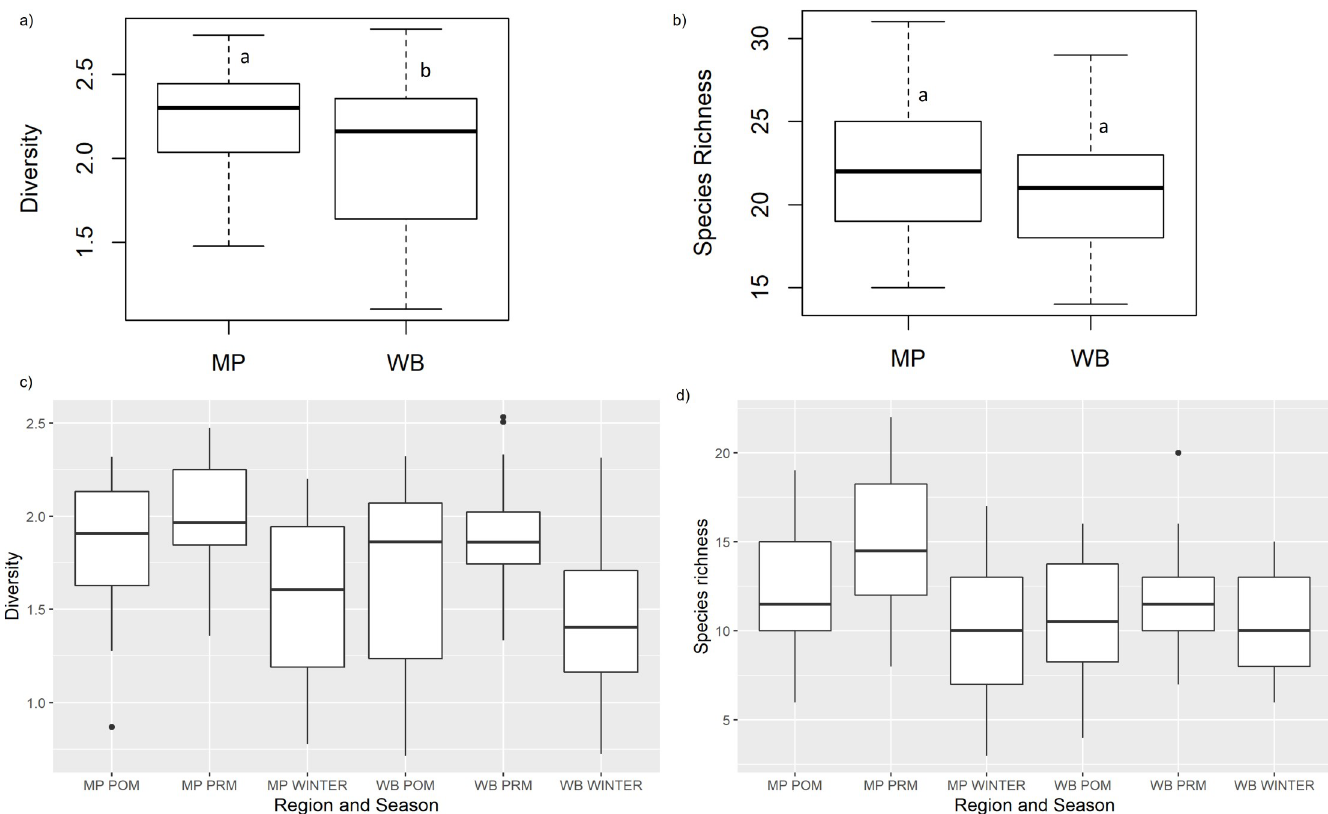
Fig 3. Comparison of combined and temporal patterns in diversity and richness across MP and WB. a) Comparison of overall diversity between MP and WB show significant difference (t = -2.21, p-value = 0.03) but not in b) overall species richness (t = -1.42, p-value = 0.16). Temporal patterns in c) seasonal diversity (H’) and d) seasonal species richness (SR) in Madhya Pradesh and West Bengal reveal pre monsoon to have the most abundant and diverse community. Lines, boxes, and whiskers depict medians, interquartile ranges (IQR), and 1.5xIQR of the estimated H’ and SR, respectively.